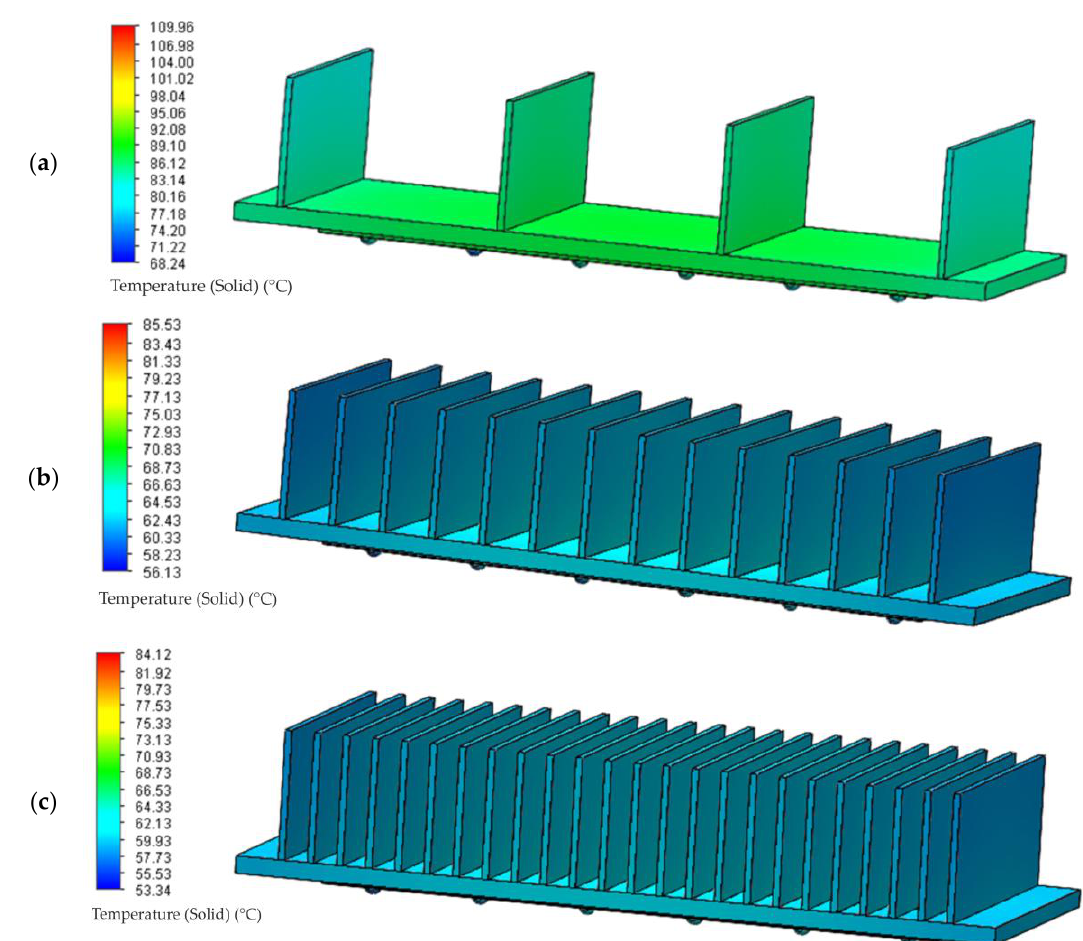
Figure 10. Temperature distribution of the LED panel with a radiator of a different number of fins: ( a ) 4 fins, ( b ) 14 fins and ( c ) 24 fins.